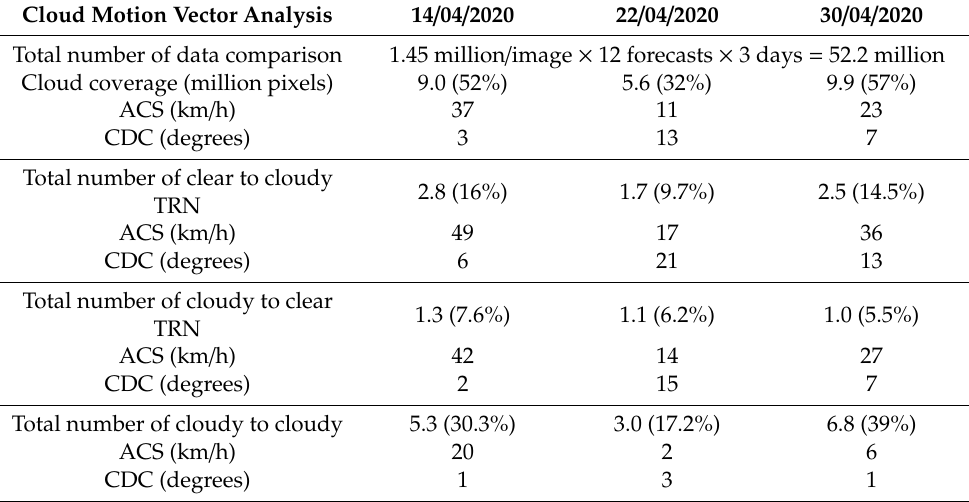
Table 1. The cloud motion vector characteristics and statistics of the selected days in terms of average cloud speed (ACS) and cloud direction change (CDC) under all-sky conditions, clear to cloudy and cloudy to clear sky condition transition (TRNs) and cloudy persistence during the studied 3 h time horizon, i.e., from 9:15 to 12:15